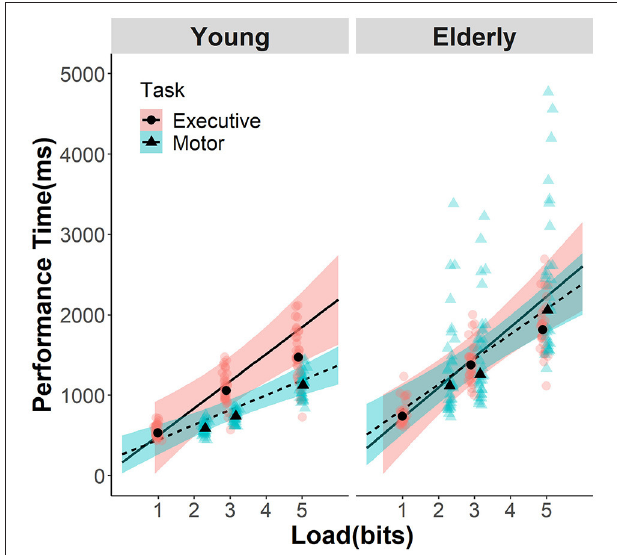
FIGURE 1 | Efficiency functions for movement time in Fitts’ task and reaction time in MFT. The data of young participants and GLMM estimates are presented in the left panel, while those for the elderly participants in the right panel. Data and estimates for MFT are indicated with dots, pink color, and solid lines, whereas those for Fitts’ task were indicated with triangle, dashed lines, and cyan color. The shaded area indicates the 95% CI of the GLMM estimation. Transparent background symbols indicate the mean data of each individual participants, and the black foreground symbols indicate the mean of each group at the load level included in the